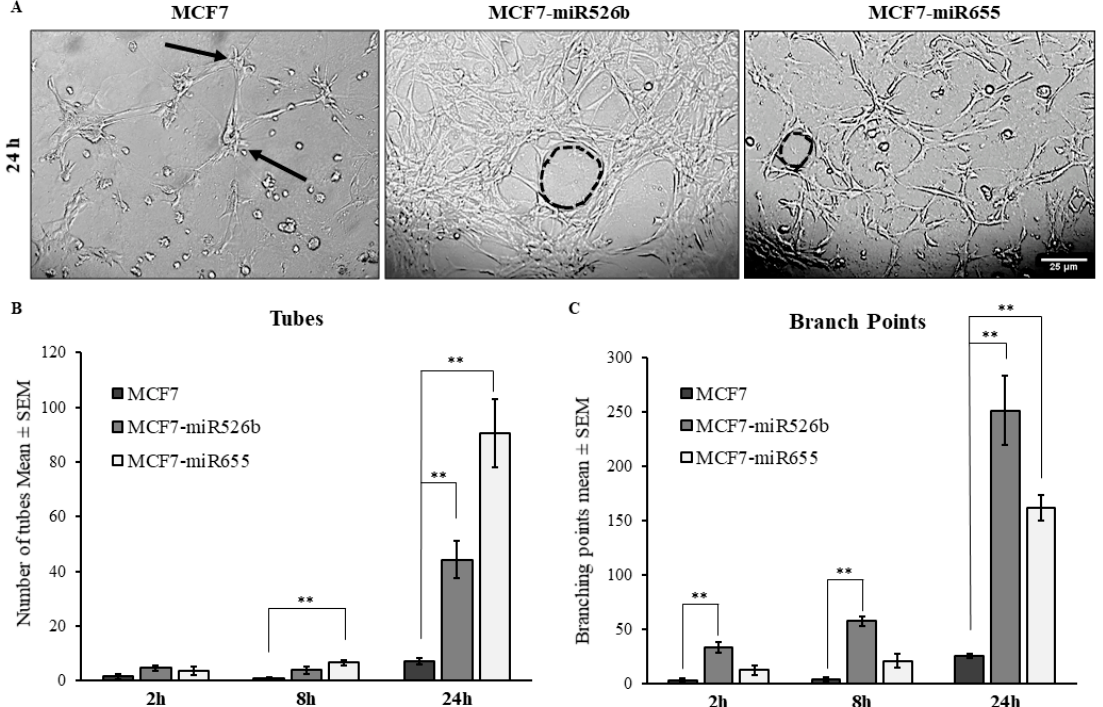
Figure 4. Overexpression of miR526b and miR655 results in an increase of tube formation of HUVECs. ( A ) Visual representation of tube formation of HUVECs at the 24 h time point in conditioned media from MCF7, MCF7-miR526b, or MCF7-miR655 cell line. Both tubes (dotted circle) and branching points (arrows) were greater in MCF7-miR526b or MCF7-miR655 conditioned media compared with MCF7 conditioned media. ( B ) Quantitative data represent number of tubes per time point, per condition. ( C ) Quantitative data represent number of branching points per time point, per condition. Quantitative data presented as the mean ± SEM of three biological replicates, including three experimental replicates per biological replicate; ** p < 0.01.